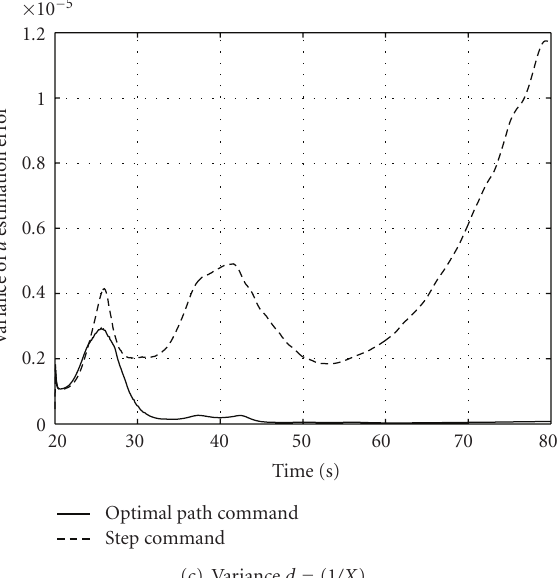
(b) With optimal guidance